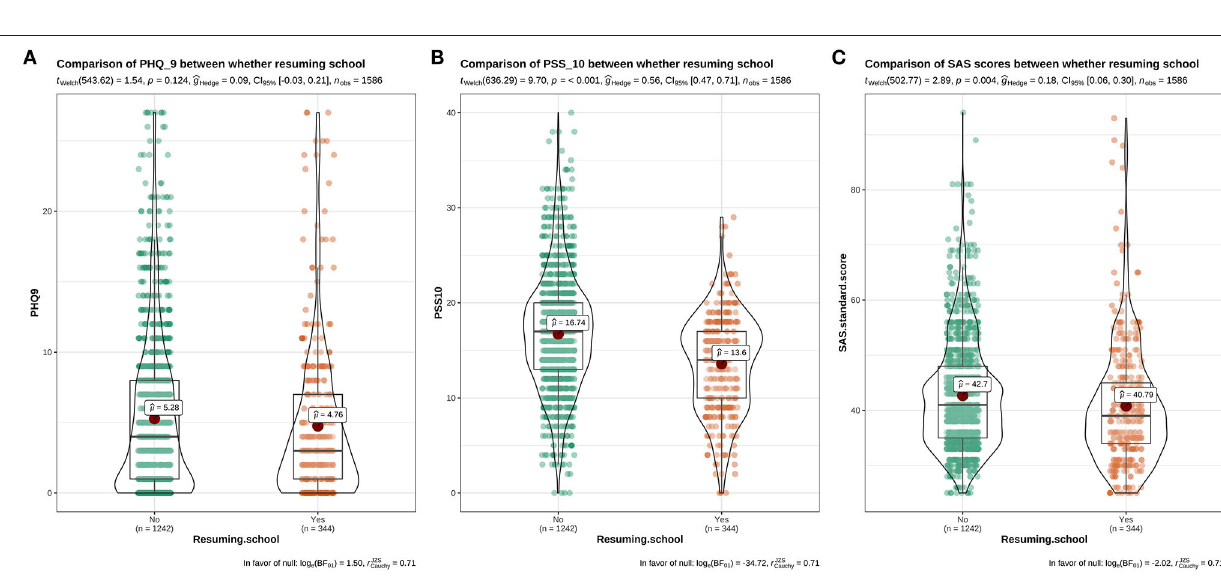
FIGURE 5 | The distribution maps of PHQ-9, PSS-10, and SAS scores in resuming-school or not groups. (A) Distribution of PHQ-9 scores in the returned group and the non-returned group; (B) Distribution of PSS-10 scores in the returned group and the non-returned group; (C) Distribution of SAS scores in the returned group and the non-returned